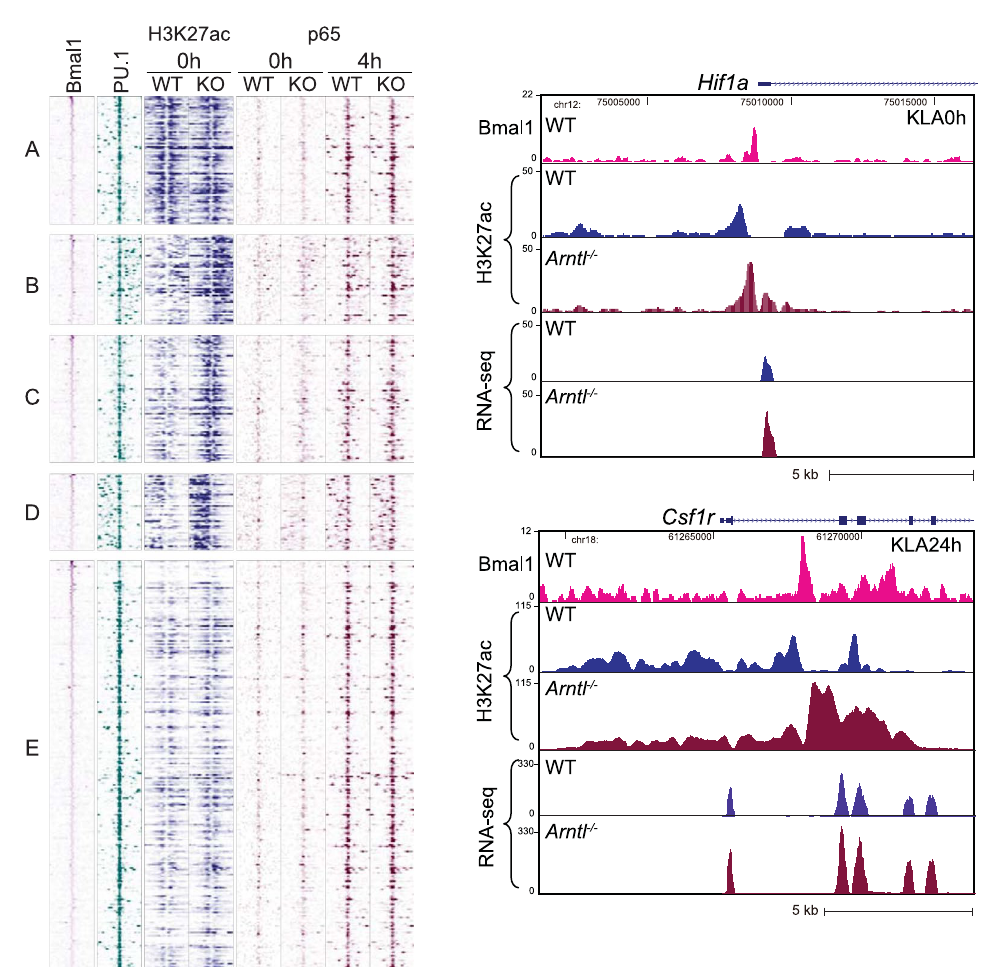
Figure 5. Loss of Bmal1 enhances H3K27 acetylation at Bmal1 binding sites. ( a ) Heatmap for Bmal1, PU.1 and p65 binding and H3K27 acetylation within 2 kb around the center of the top 500 Bmal1-PU1 co-binding sites in untreated cells. ChIP-seq tags for Bmal1, PU.1 and H3K27ac at baseline, were grouped into 5 clusters using the K-means clustering algorism. Corresponding p65 ChIP-seq tag densities in cells at baseline (0 h) and 4 h after KLA treatment are also shown. ( b ) Genome browser snapshots showing Bmal1 and H3K27ac ChIP-seq and RNA-seq signals at Hif1a and Csf1